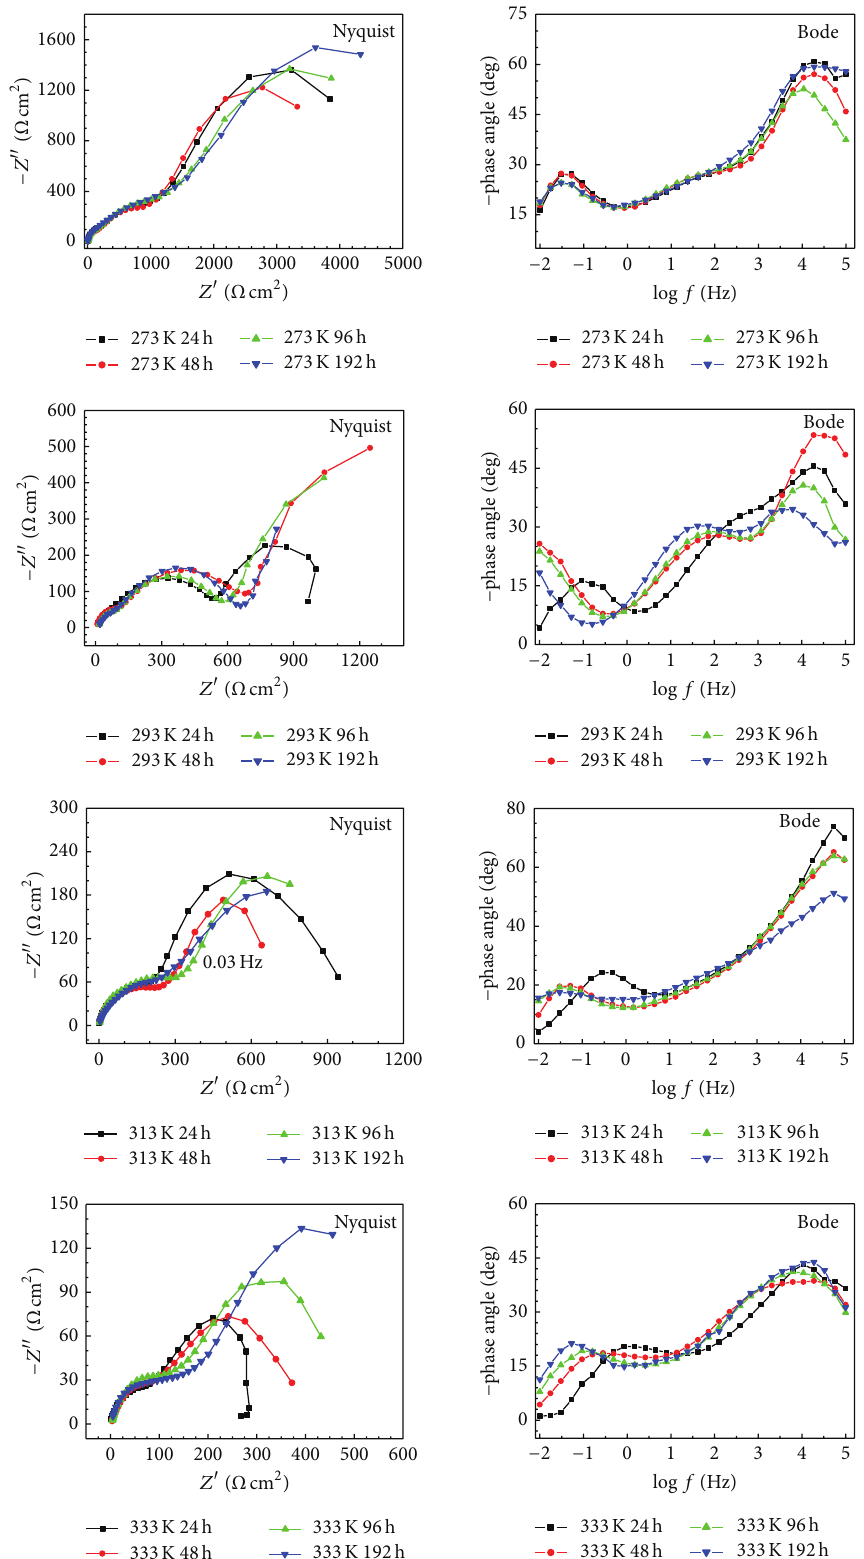
Figure 5: EIS curves of galvanized steel in CRS solution at 0.1MPa under different